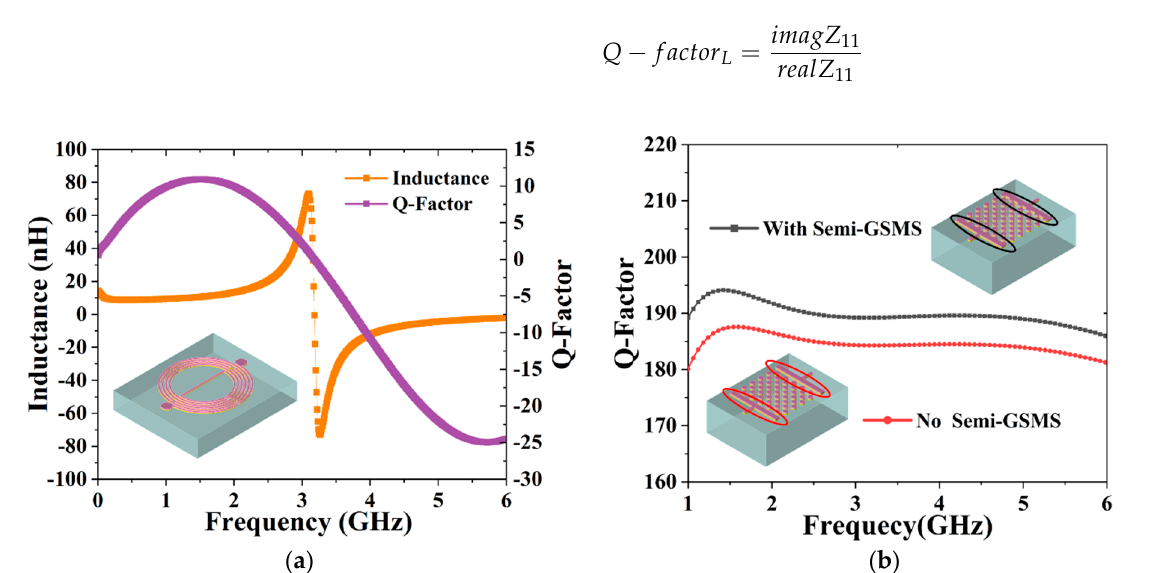
Figure 2. ( a ) Simulated inductance and Q-factor of the asymmetrical spiral inductor. ( b ) Simulated Q-factor of the capacitor with semi-GSMS and without semi-GSMS.